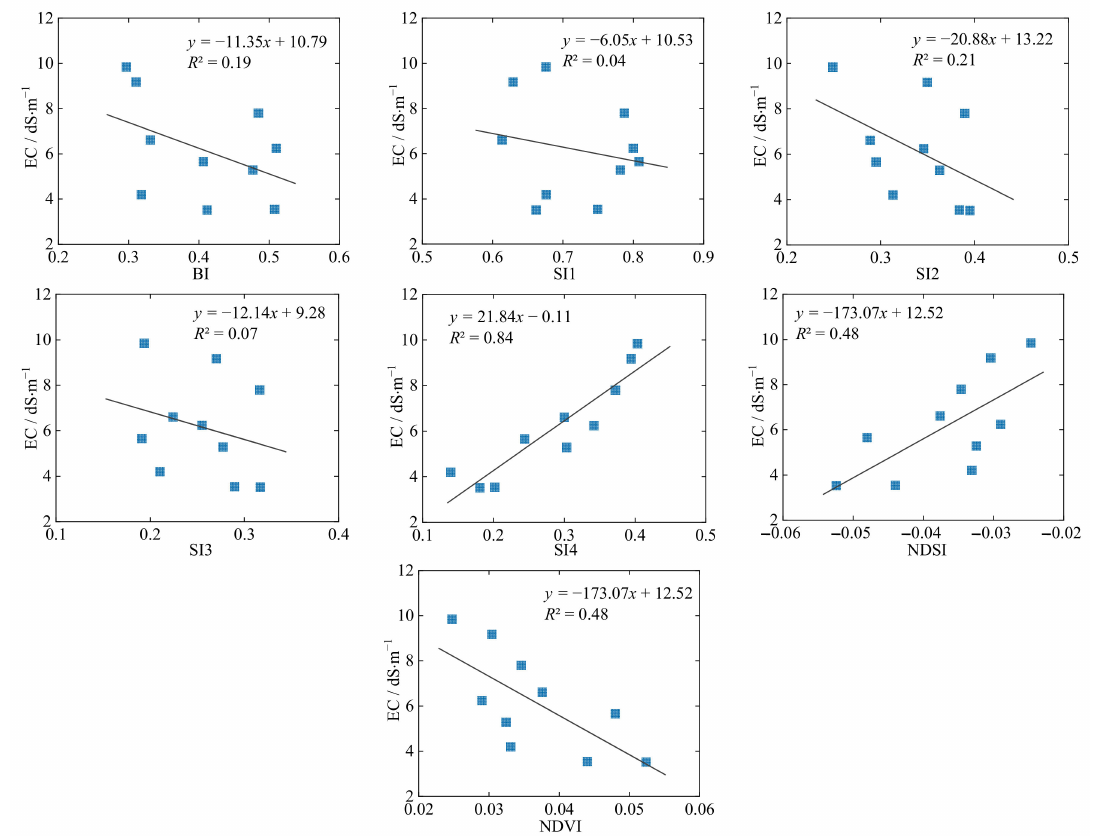
Figure 4. Scatterplots of EC and salinity indices derived from Landsat data, including BI, SI1, SI2, SI3, SI4, NDSI, and NDVI. Table 3. Correlation coefficients between the soil salinity (EC) and seven potential salinity indices.